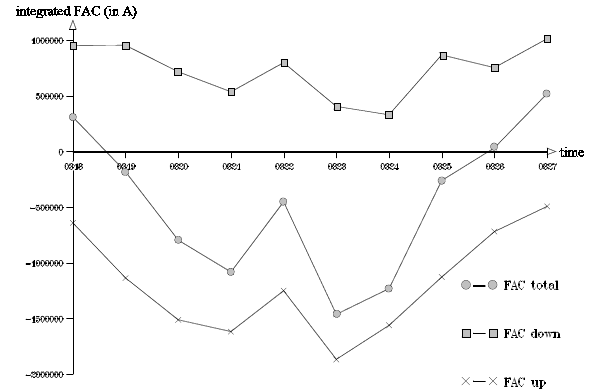
Fig. 10. Integrated upward FAC (crosses), integrated downward FAC (squares), and integrated total FAC (dots) in A over the analy- sis region, as a function of time over the analysis